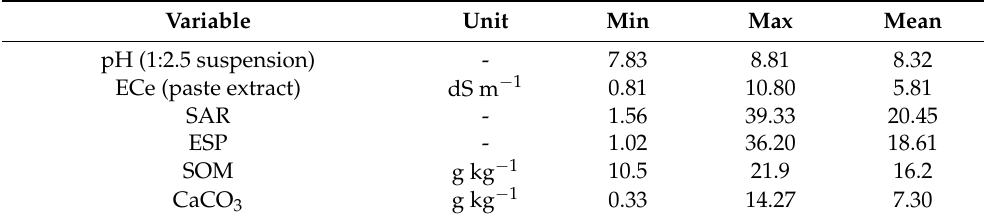
Table 1. Basic variables for the sixty-six soil samples’ studied soil